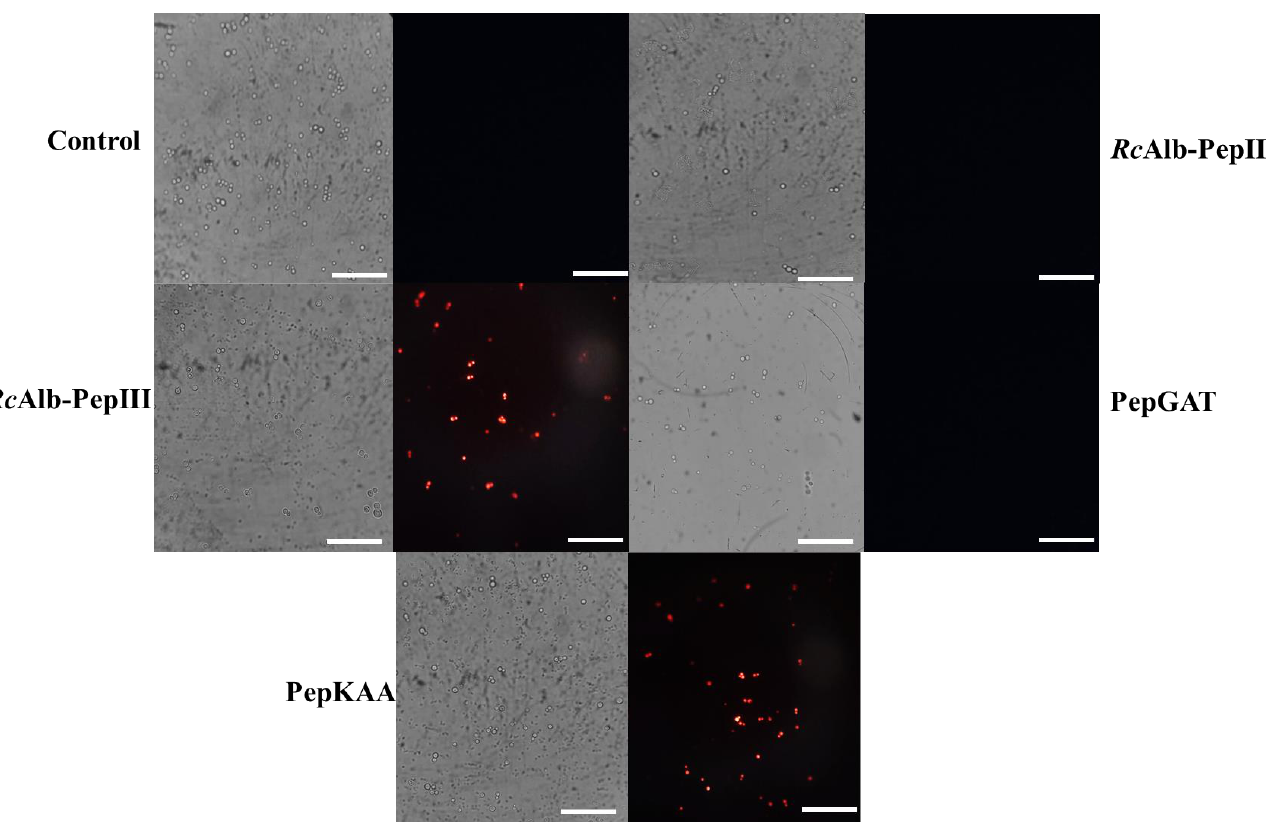
Figure 5. Effect of the antioxidant agent, ascorbic acid, in the membrane pore formation induced